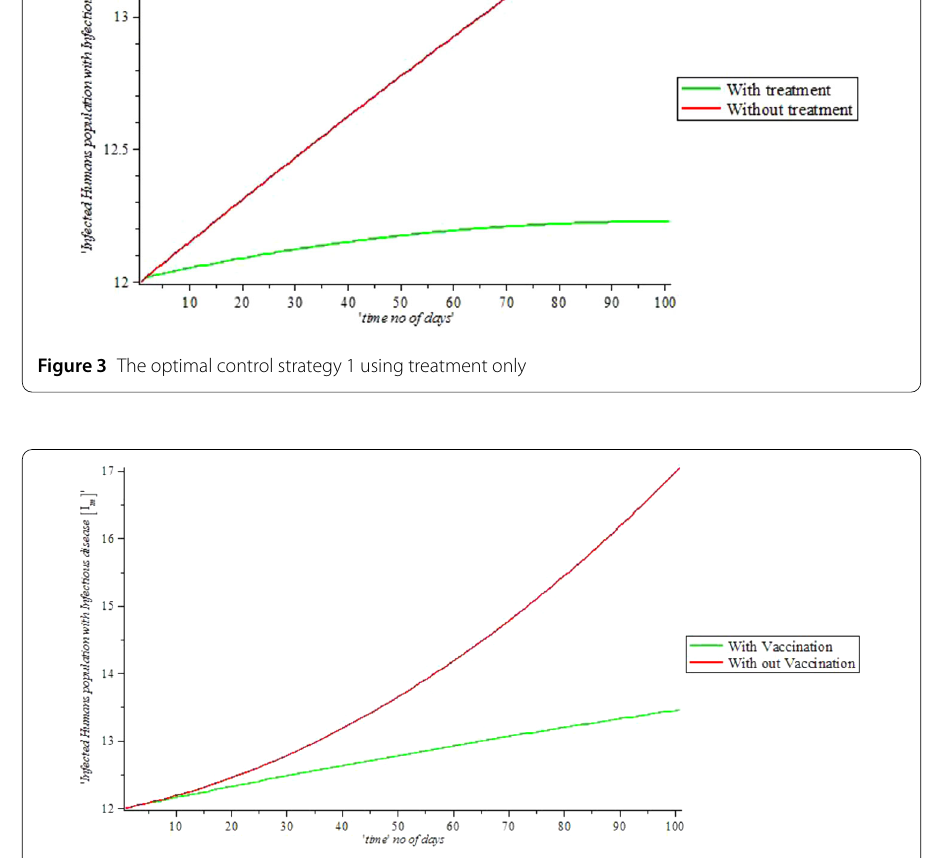
ment in and out of the population during the outbreak of the epidemic. The reproduction number R 0 was found to be a (cid:2)δ R 0 = μ ( μ + b + δ )( b + e + μ